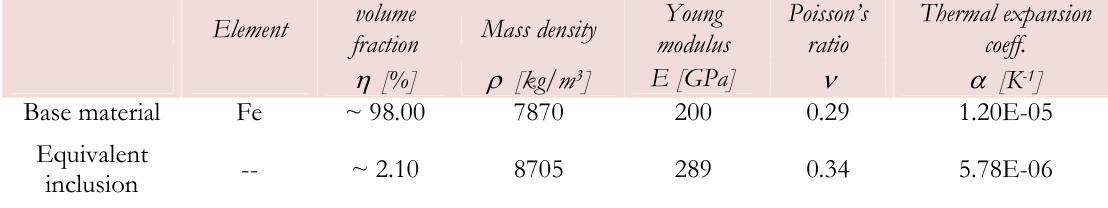
Table 2: Mean physical and mechanical parameters of the base material and the equivalent inclusion in a carbon steel D6ac.